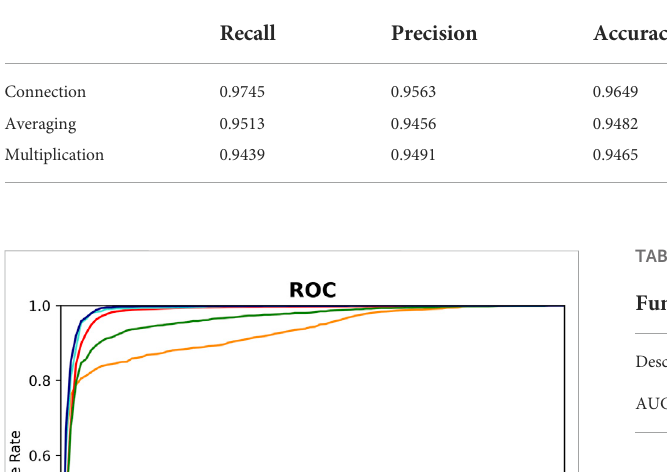
TABLE 1 The six evaluation metrics results of the three merging methods.